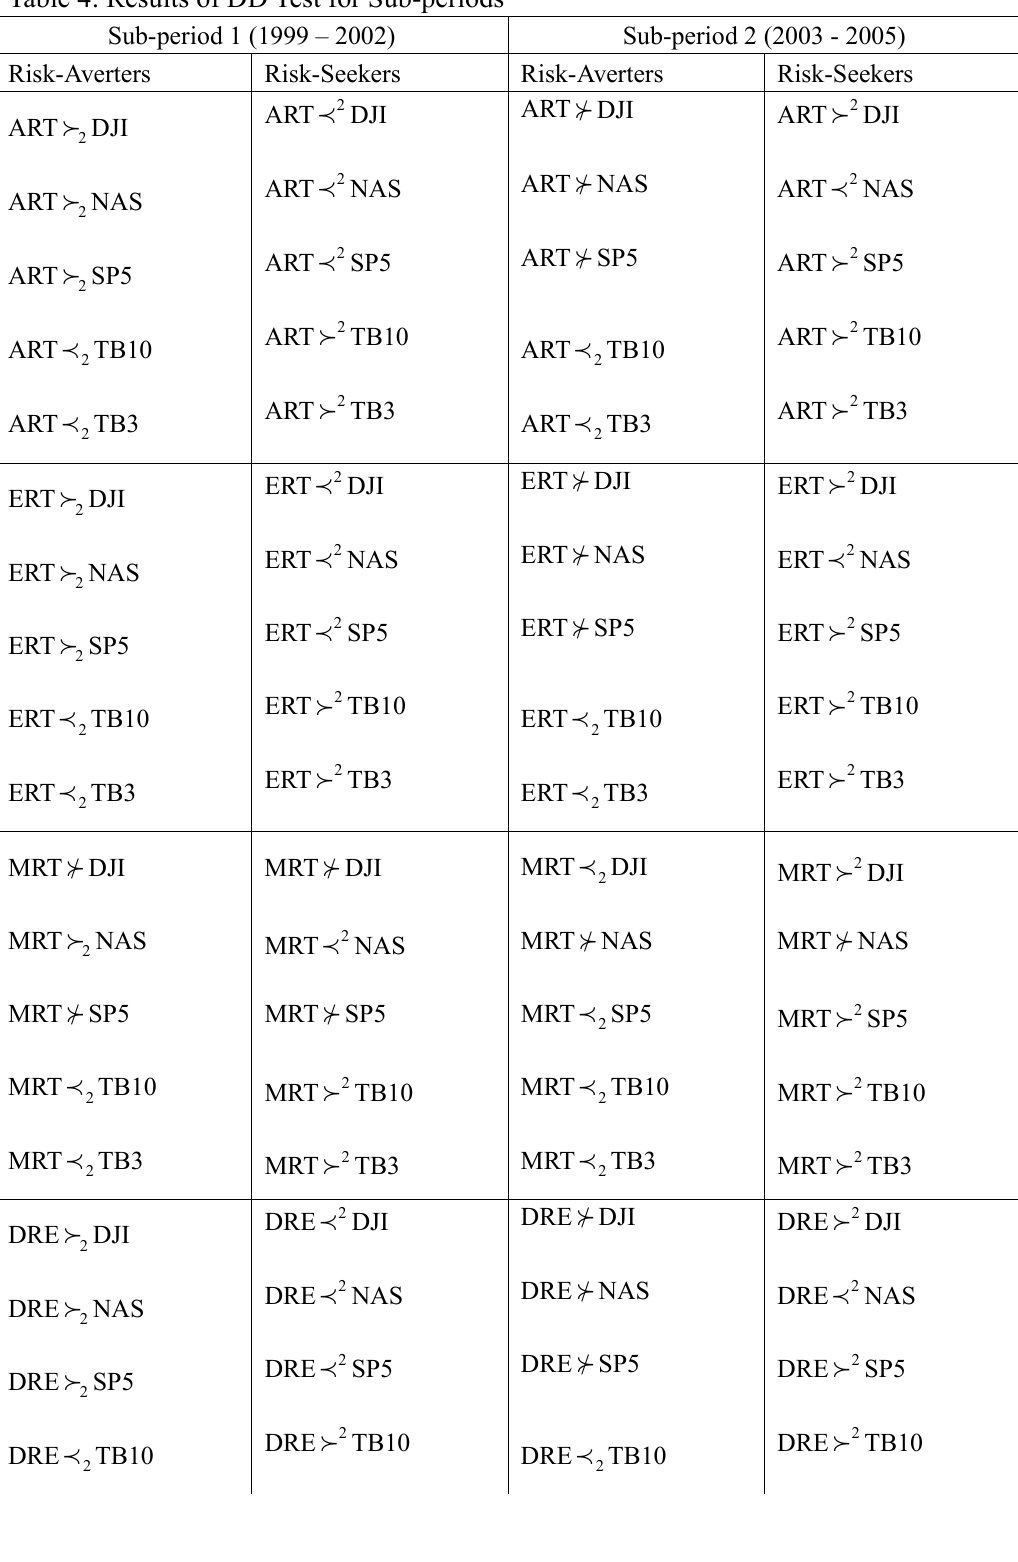
Table 4: Results of DD Test for Sub-periods Sub-period 1 (1999 –